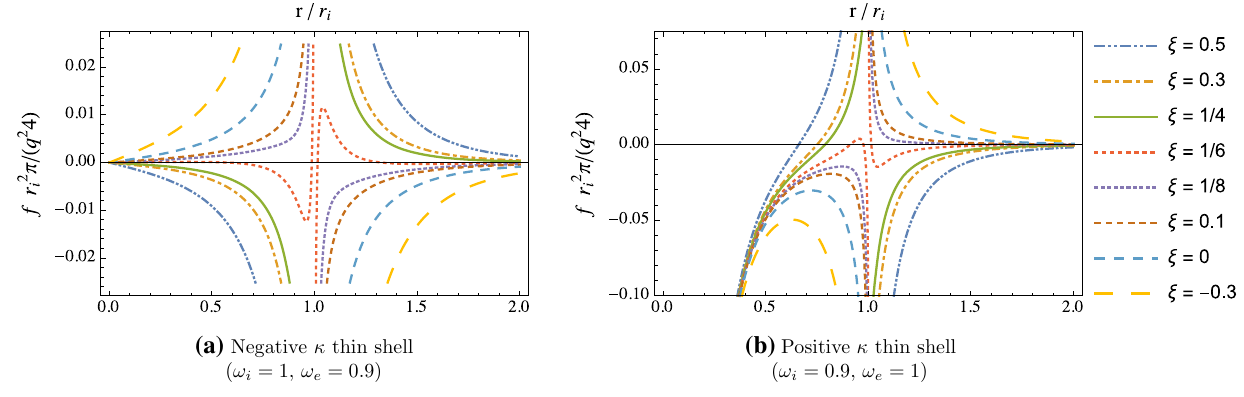
π r 2 i f as a function of r / r i in a Type I spacetime with r i m = 1 and different coupling constants 4 q 2